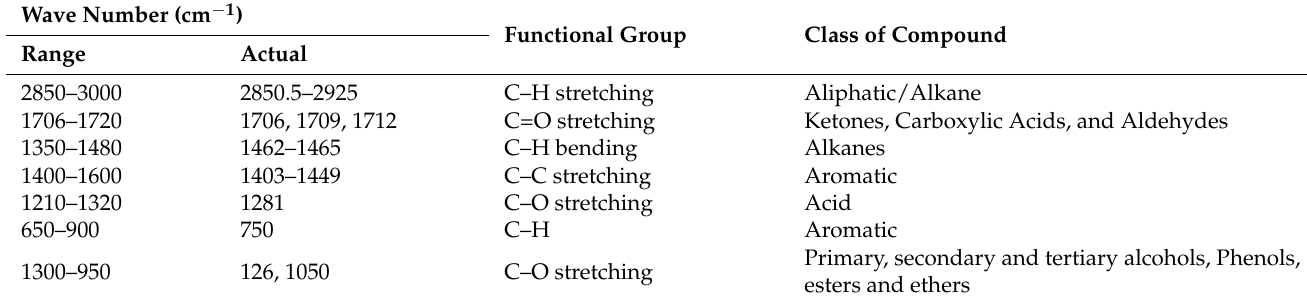
Table 3. FTIR functional group compositions of produced bio-oil.